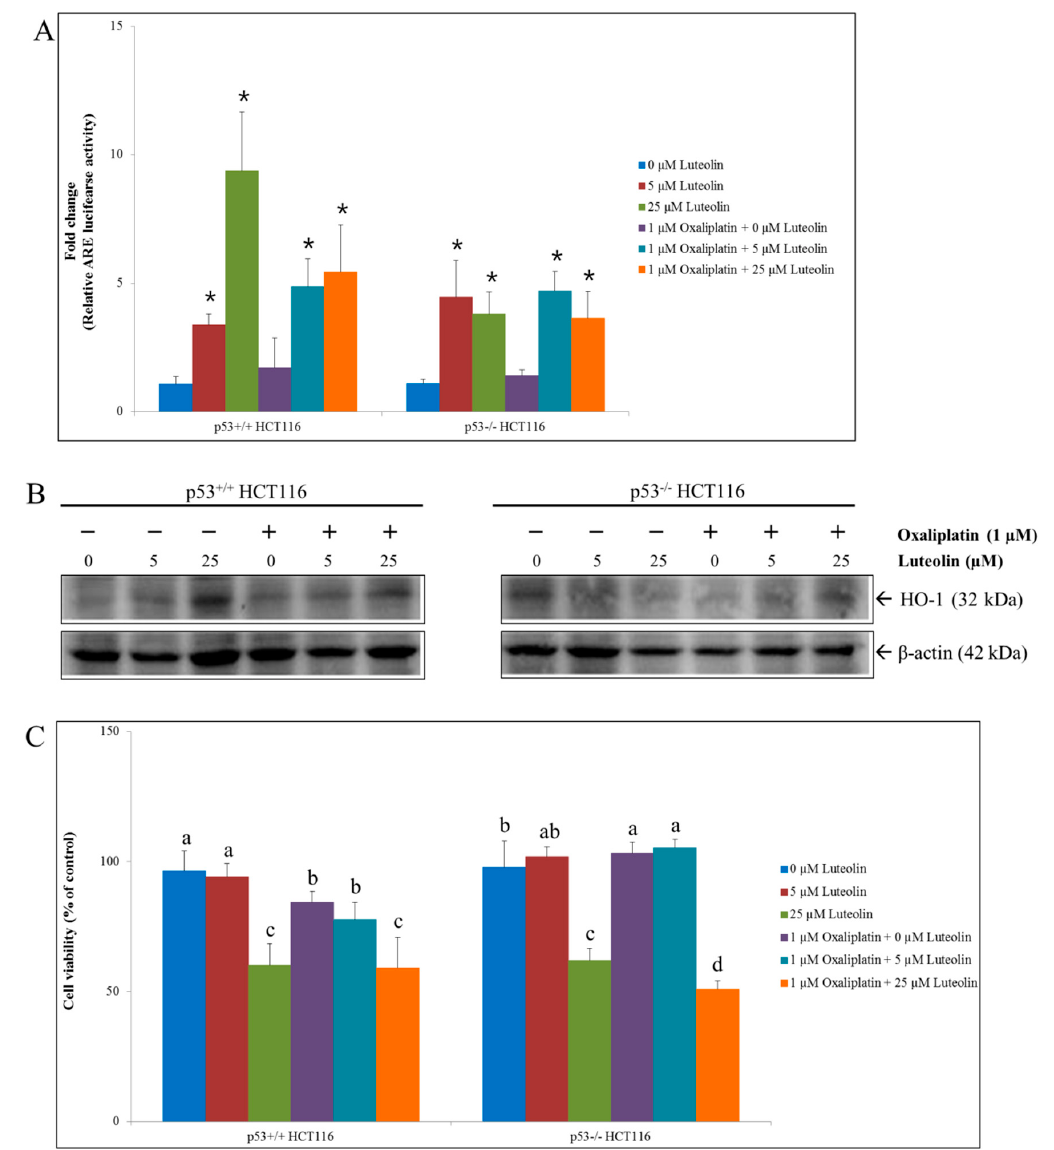
Figure 2. ARE-luciferase activity, HO-1 protein expression, and cell viability in p53 +/+ and p53 -/- HCT116 cells in the presence of luteolin and/or oxaliplatin. Cells were seeded in a 6-well plate, a 100-mm dish, or a 96-well plate and treated with 5 or 25 μ M luteolin in the absence or presence of 1 μ M oxaliplatin at for 24 h, followed by measurement of the ARE activity, Western blot analysis for HO-1 expressions or cell viability assay. ( A ) Relative ARE-luciferase activity. Data are expressed as mean ± SD of three independent experiments. A significant difference compared to the control group at p < 0.05 was indicated by an asterisk. ( B ) Representative Western blots of protein expression changes of HO-1. ( C ) Relative cell viability assayed using a CCK-8 kit. Data are expressed as mean ± SD of three independent experiments. A significant difference compared among the groups at p < 0.05 was indicated by different alphabetical letters.